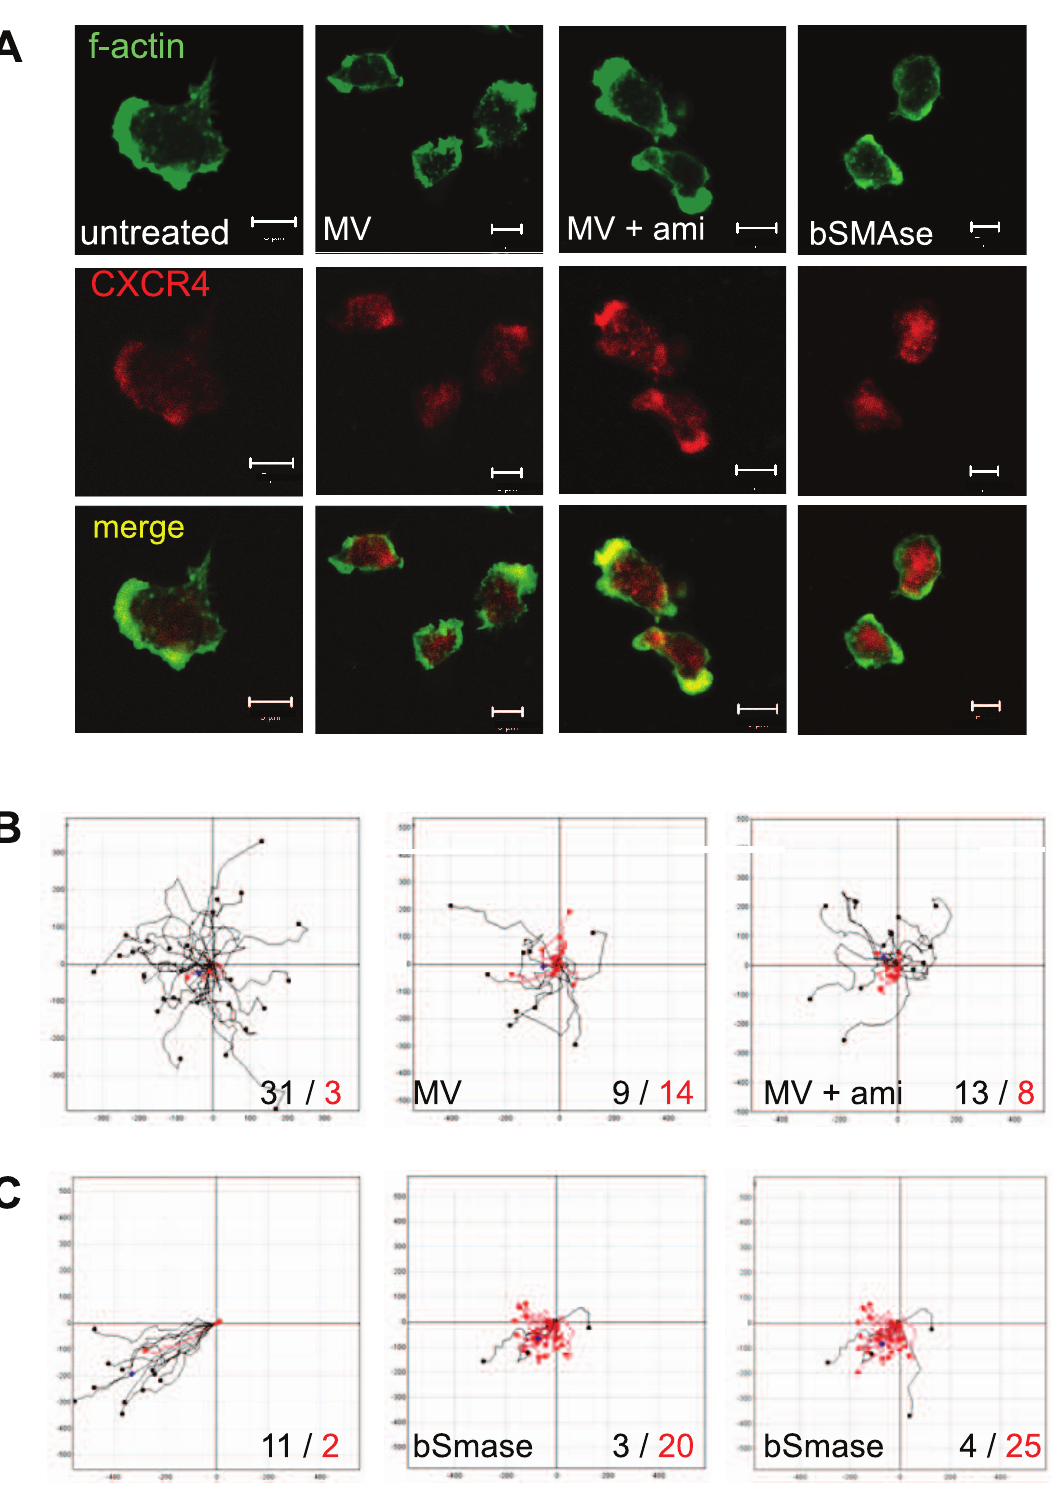
Figure 5. Ceramide accumulation abolishes redistribution of CXCR4 and affects T cell chemotactic motility. (A) T cells left untreated (first column) or exposed to MV (second column) alone or after a 2 h pretreatment with amitriptilyne (third column) or to bSMase (fourth column) were seeded onto FN and stained for f-actin and CXCR4. Size bars represent 5 m m. (B and C) T cells were left untreated (each: left panel) or pretreated with amitriptyline ((B), right panel) or not before exposure to MV for 2 h at 4 u C ((B), middle panel) or treated with bSMase ((C), middle and right panels) for 2 hrs at 37 u C and seeded onto FN with addition of SDF-1 (1,5 m g/ml). Migration of cells on FN in response to SDF-1 was recorded over a time period of 10 min and the individual velocities of cells and their trajectories were calculated using ImageJ software. Tracks of cells faster than an arbitrary velocity threshold of 7 m m/min in B, or 9 m m/min in C, are indicated in black, those slower in red in each panel. Examples shown are representative of three individual experiments including different donors with a total of at least 120 cells recorded for each experimental setup.